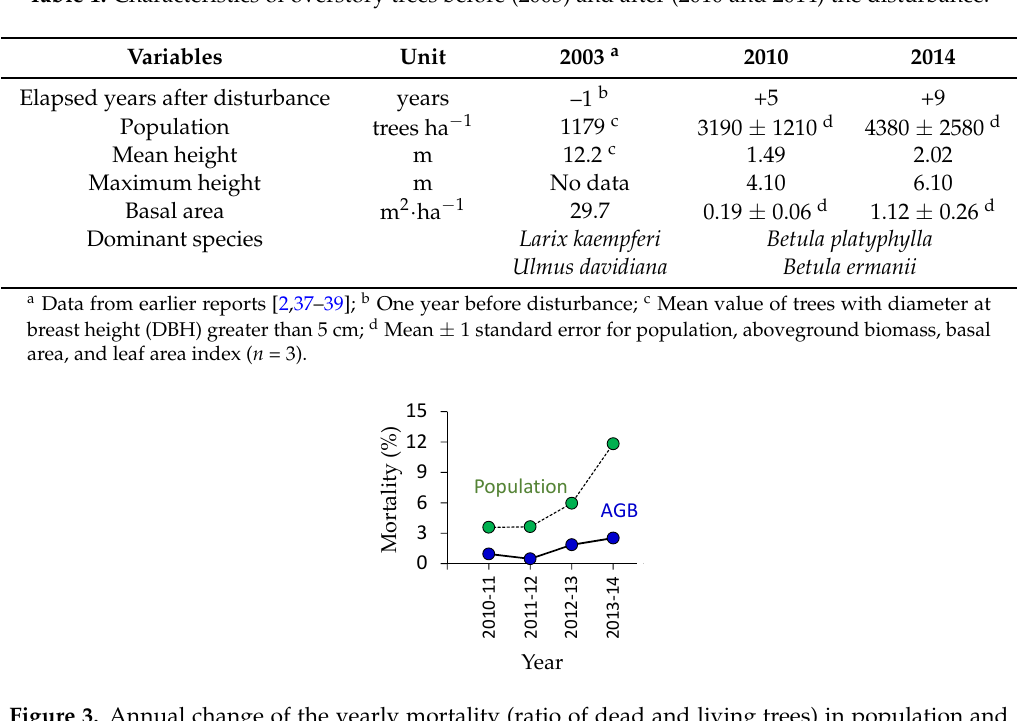
Figure 3. Annual change of the yearly mortality (ratio of dead and living trees) in population and biomass (AGB).